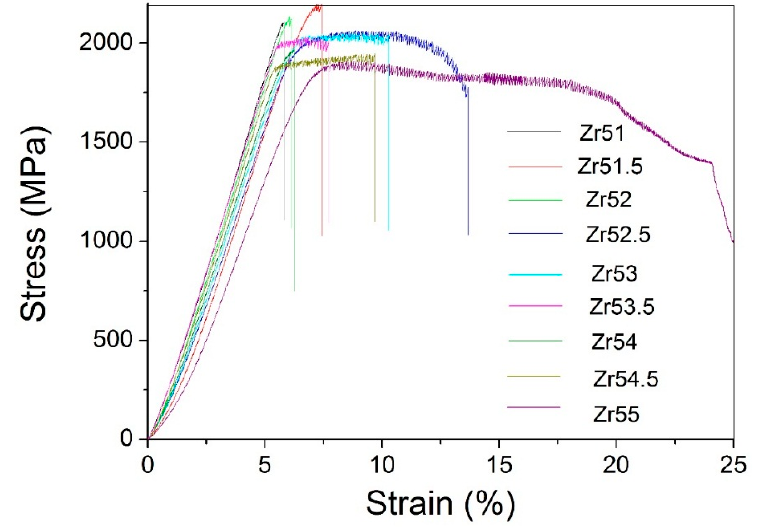
Figure 11. Room-temperature uniaxial compression stress–strain curves for the studied Zr-based BMGs.